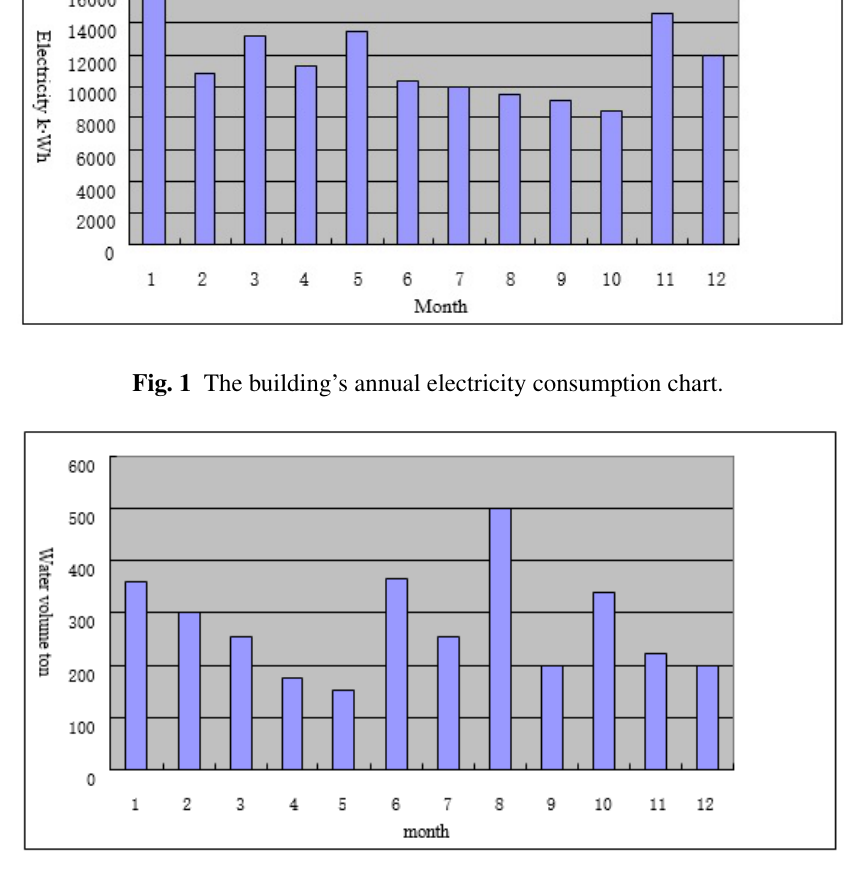
Fig. 2 The water consumption of the building in a given